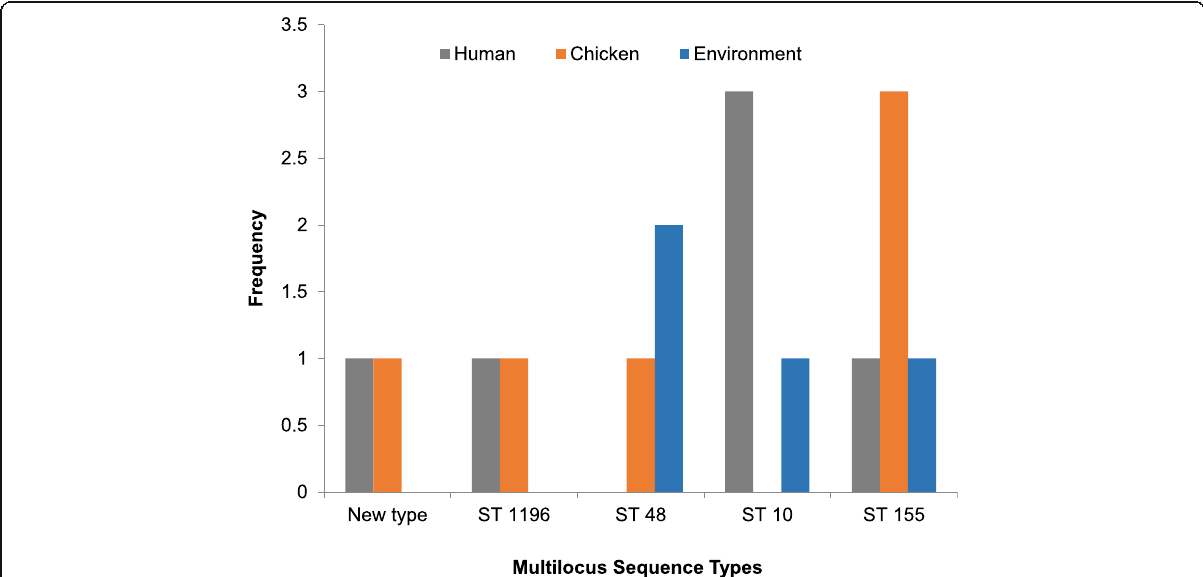
Fig. 4 Multilocus Sequence Types for ESBL-EC isolated from humans, chickens and poultry environment, Abuja, Nigeria, 2019. Each bar represents the various ESBL-EC sequence types for isolates obtained from humans, chickens and chicken farm/market